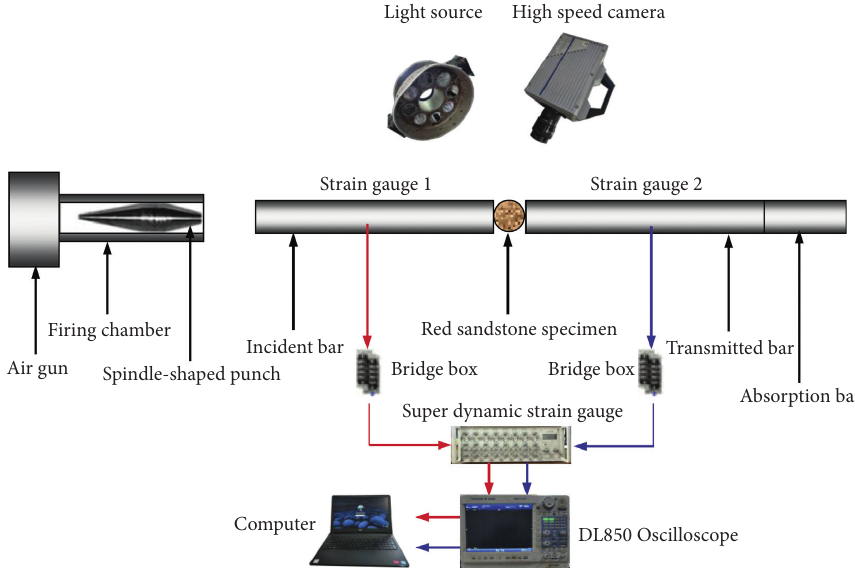
Figure 1: Diagram of the SHPB testing apparatus for the dynamic Brazilian disc tests